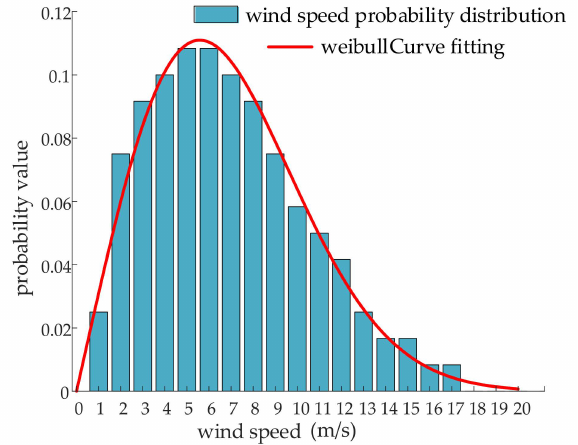
Figure 2. Fitting effect of wind speed probability distribution.